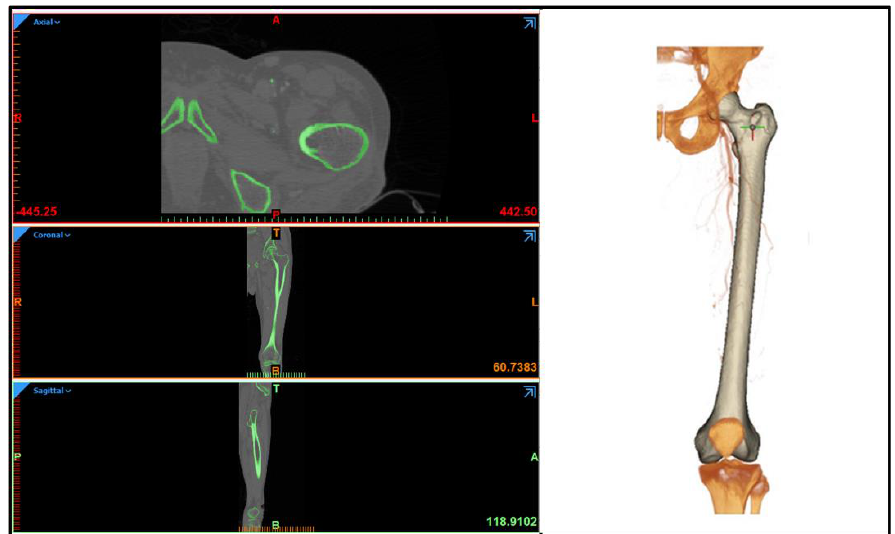
Figure A1. Representative boundary condition and hexahedral meshing ( a ) P, 80% Porosity ( b ) G, 80% Porosity.